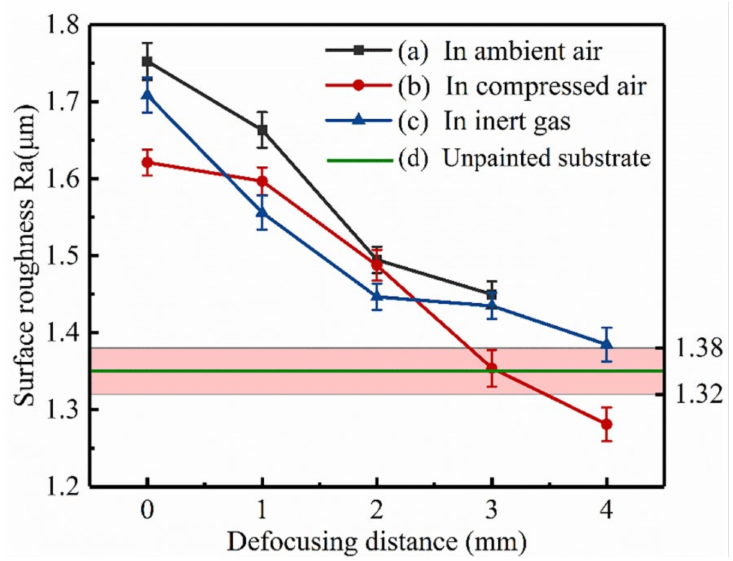
Figure 13. Surface roughness of samples laser scanned 3 times: ( a ) in ambient air, defocus distance 0–+3 mm; ( b ) in compressed air, defocus distance 0–+4 mm; ( c ) in inert atmosphere, defocus distance 0–+4 mm; ( d ) unpainted